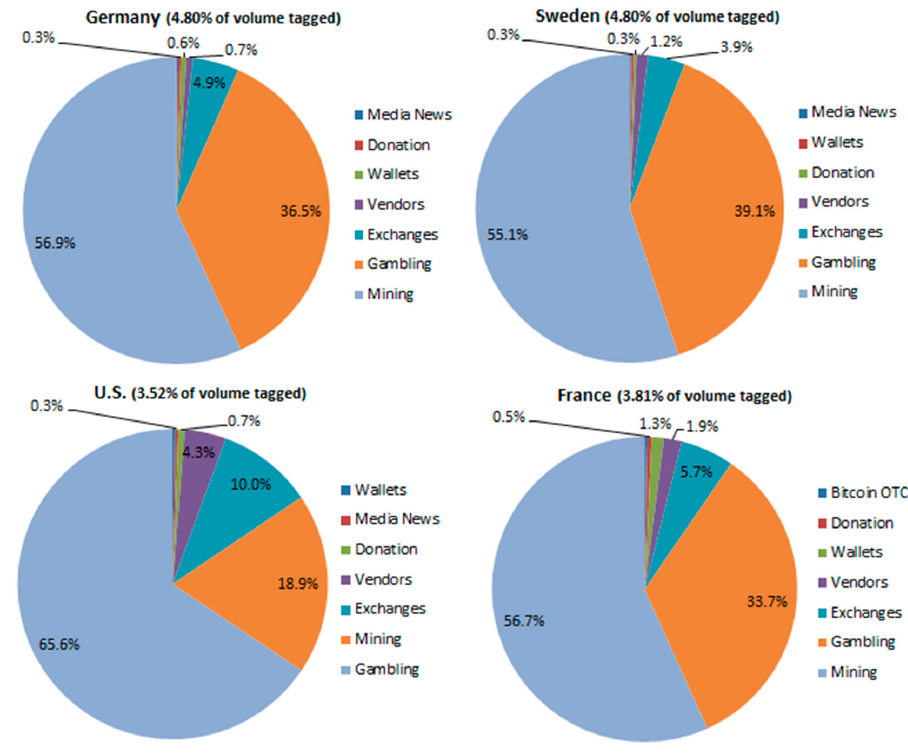
Figure 18. Transaction Volume in BTC per Business Category in Developed Countries.